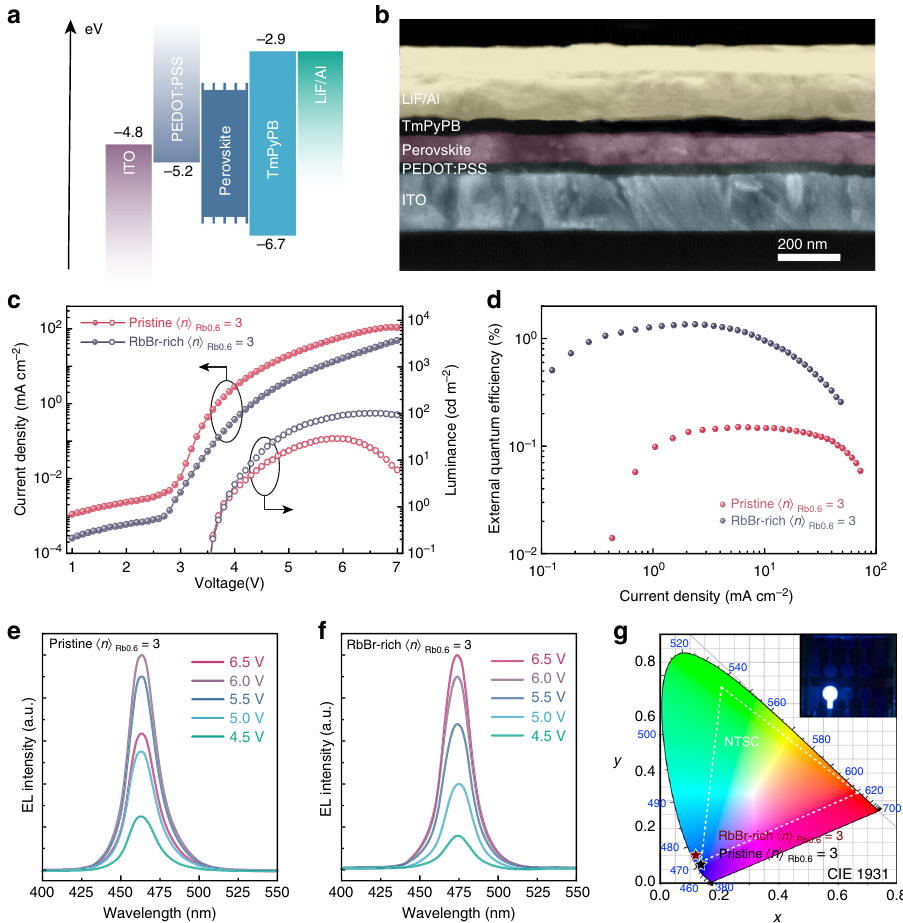
Fig. 4 Optoelectronic characteristics of the PeLEDs. a Band alignment of each function layer in devices. b SEM cross-sectional image of the RbBr-rich < n > Rb0.6 = 3 based devices. c I – V and L – V curves for pristine and RbBr-rich < n > Rb0.6 = 3 devices. d EQE characteristics of pristine and RbBr-rich < n > Rb0.6 = 3 devices. EL spectra of ( e ) pristine and ( f ) RbBr-rich < n > Rb0.6 = 3 at different voltage bias. g The corresponding Commission Internationale de l ’ Echlaiage (CIE) coordinate of pristine and RbBr-rich < n > Rb0.6 = 3 devices, and the inset image shows the electroluminescence of RbBr-rich < n > Rb0.6 = 3